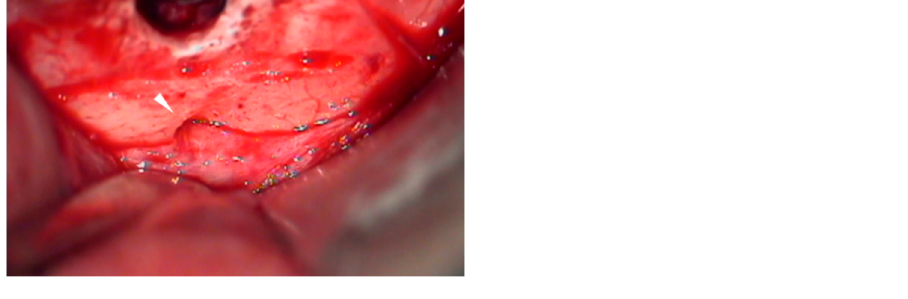
Figure 6. Clinical features of the mental foramen and nerve bundle (white triangle) that are detected during the surgical procedure.